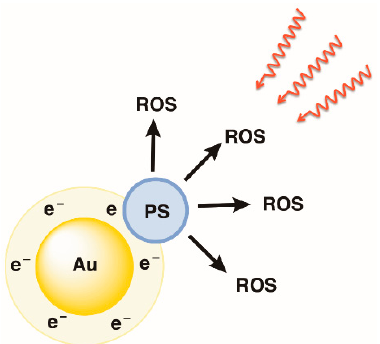
Figure 4. Plasmonic AuNP. The local electric field caused by conductance electrons potentiates the optical field near the surface and enhances the fluorescence or photoactivity of the attached PS (adapted from Reference [69]).